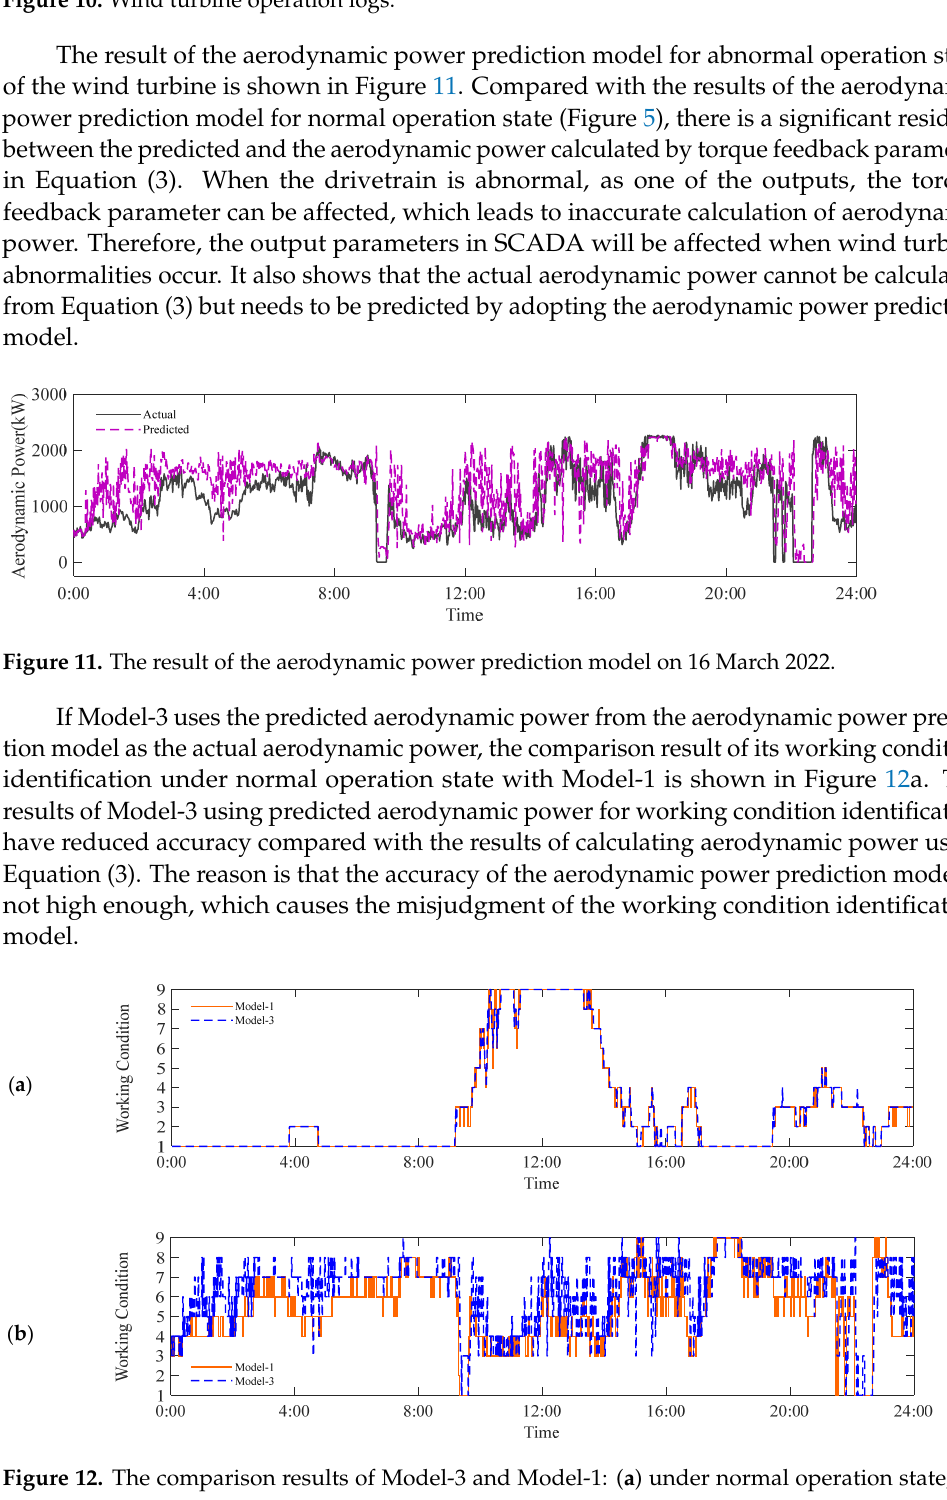
Figure 12. The comparison results of Model-3 and Model-1: ( a ) under normal operation state; ( b ) under abnormal operation state.